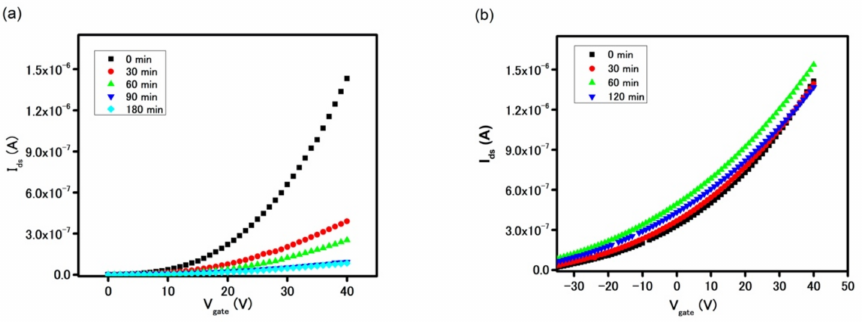
Figure 4. FET characteristics curves of the sensor with ( a ) 10 nm and ( b ) 30 nm Al 2 O 3 after incubation in DI water in different time